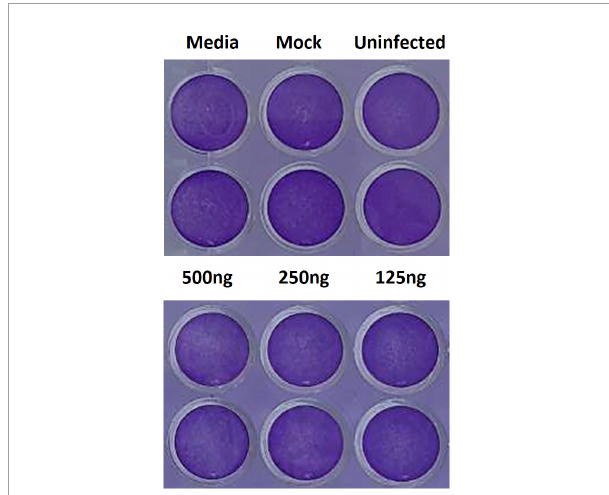
FIGURE5 Treatment with liposome-encapsulated PSCT is not associated with evident cytotoxicity. Cell cultures were treated with liposome-encapsulated PSCT at applicable doses (125, 250, and 500 ng per well), mock-treated or untreated as indicated in the label. Then, 24 h p.i. the supernatants were removed and cells were fixed with 4% formaldehyde and stained with 0.1% crystal violet dye solution. As shown in the recorded images no substantial PSCT treatment associated cytotoxicity was observed.